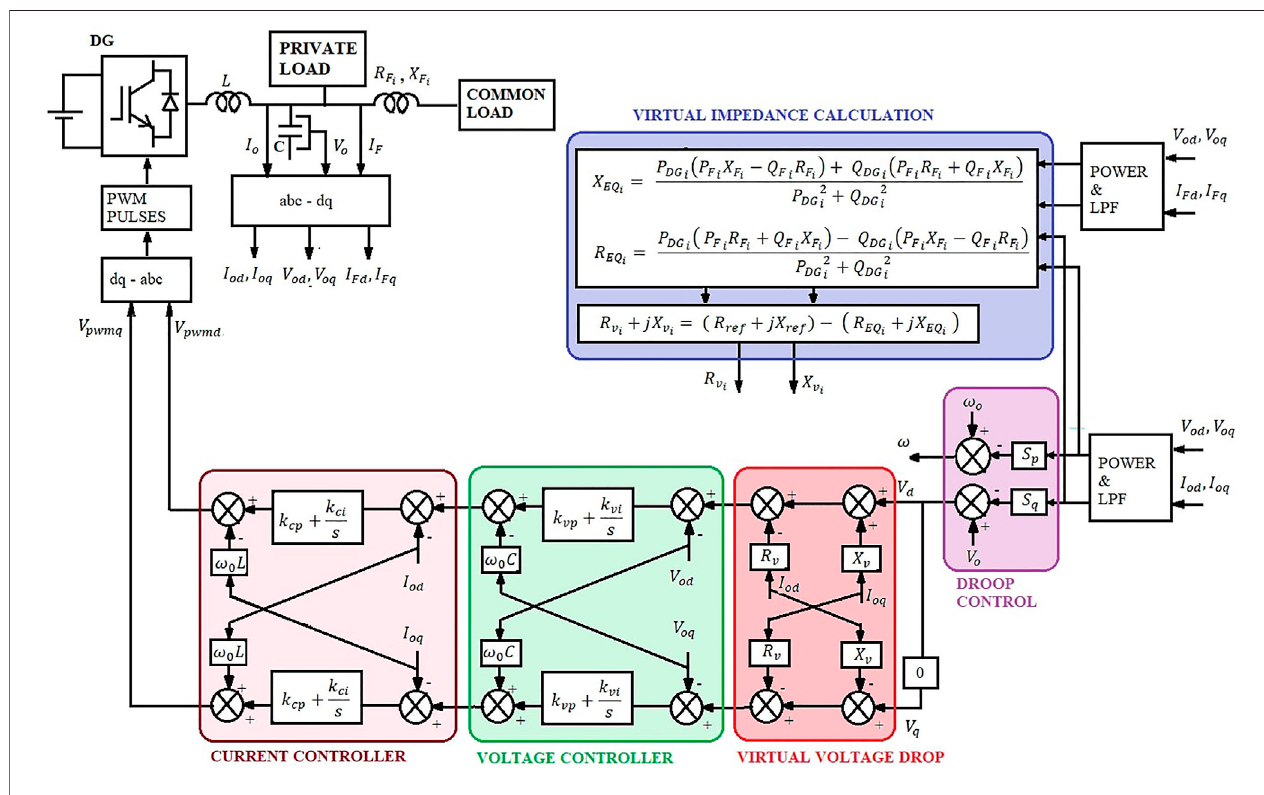
FIGURE 3 | Block diagram for overall control scheme for power sharing.